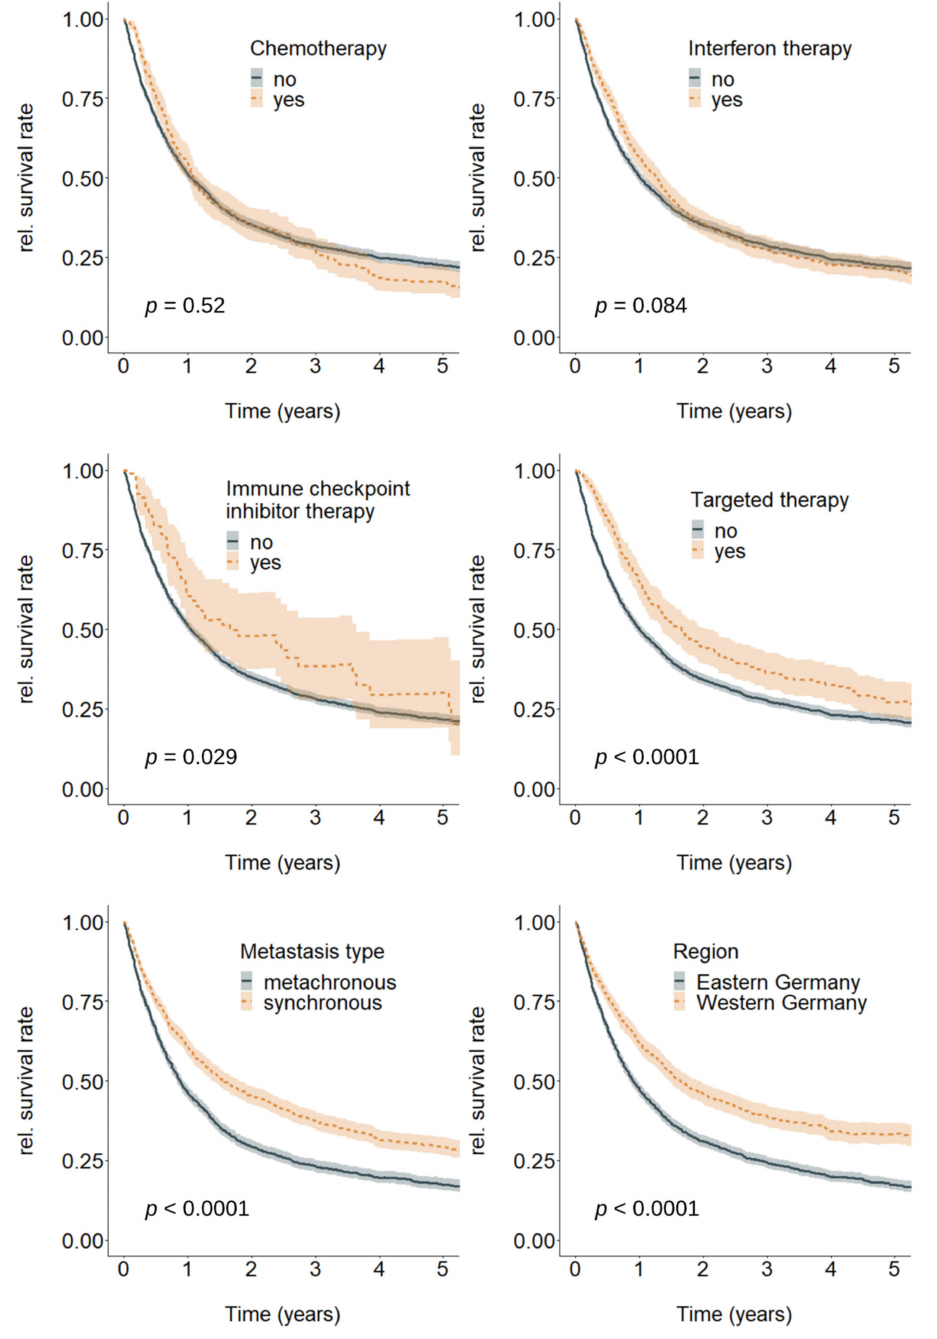
Figure 2. Overall relative survival by chemotherapy (no; yes), interferon therapy (no; yes), immune checkpoint inhibitor therapy (no; yes), targeted therapy (no; yes), metastasis type (metachronous; synchronous), and region (Eastern Germany, Western Germany), n = 3871. p -value shows the results of Log rank tests for di ff erences between the respective